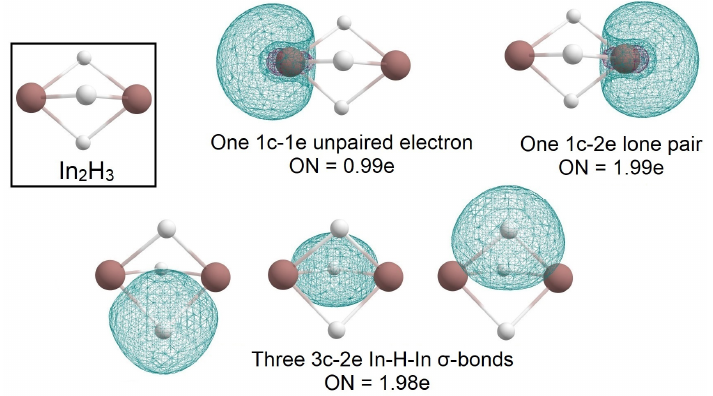
Figure 4. The chemical bonding pattern of the In 2 H 3 global minimum structure obtained by AdNDP analysis.